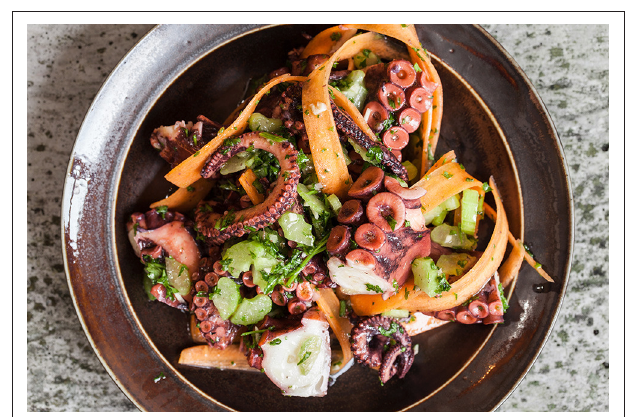
FIGURE 1 | Octopus salad, a classical South European dish made of boiled octopus arms ( Octopus vulgaris ), carrots, celeriac, garlic, and Italian parsley with olive oil, lemon juice, and oregano. Photo: permission by and courtesy of Kristoff Styrbæk.